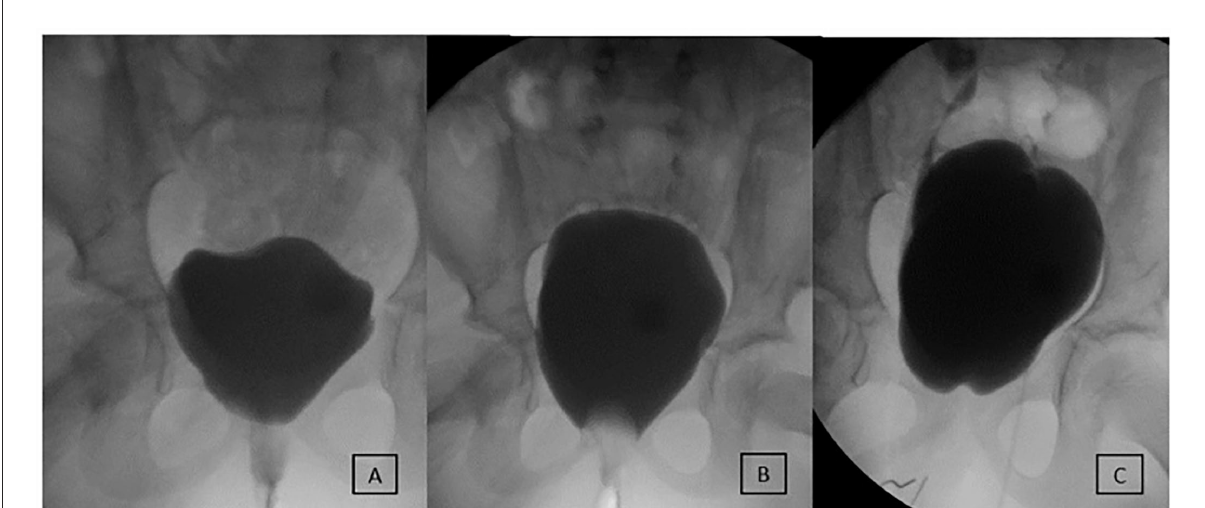
FIGURE2 Evaluation and outcome of a 7-year-old female patient with MMBNR and sling. (A) Preoperative video urodynamics demonstrates early large leak at 40ml and 2cm H 2 O without neurogenic detrusor overactivity (NDO). (B) After bladder outlet occluded with a Foley balloon, the capacity reaches 270ml with EFP 8cm H 2 O. MMBNR, in situ rectus sling, and continent catheterizable channel were performed, and she was maintained on oral anticholinergics. (C) First postoperative urodynamics demonstrate closed and elevated bladder neck and de novo right grade 3 vesicoureteral reflux (VUR) at 50ml and left grade 2 VUR at 280ml, with end-fill pressure (EFP) 24cm H 2 O. She remains fully continent then and at last follow-up without bladder augmentation or treatment of remaining grade 2 VUR.